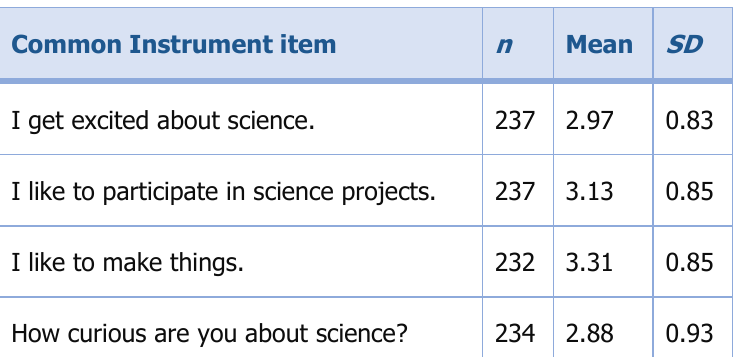
Table 2. Select Common Instrument